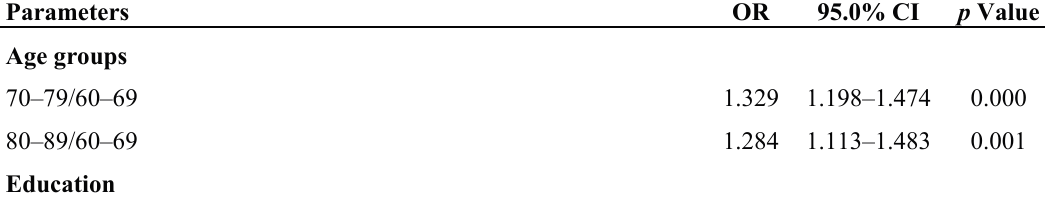
Table 5. Multivariate logistic regression on determinants of suffering from major